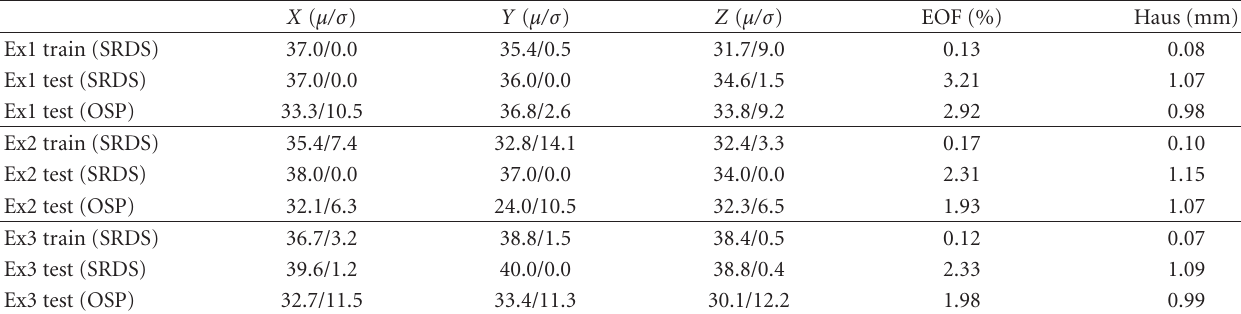
Table 8: Sparsity ( μ/σ ) along X , Y , Z axis and accuracy of in vivo LV tests.